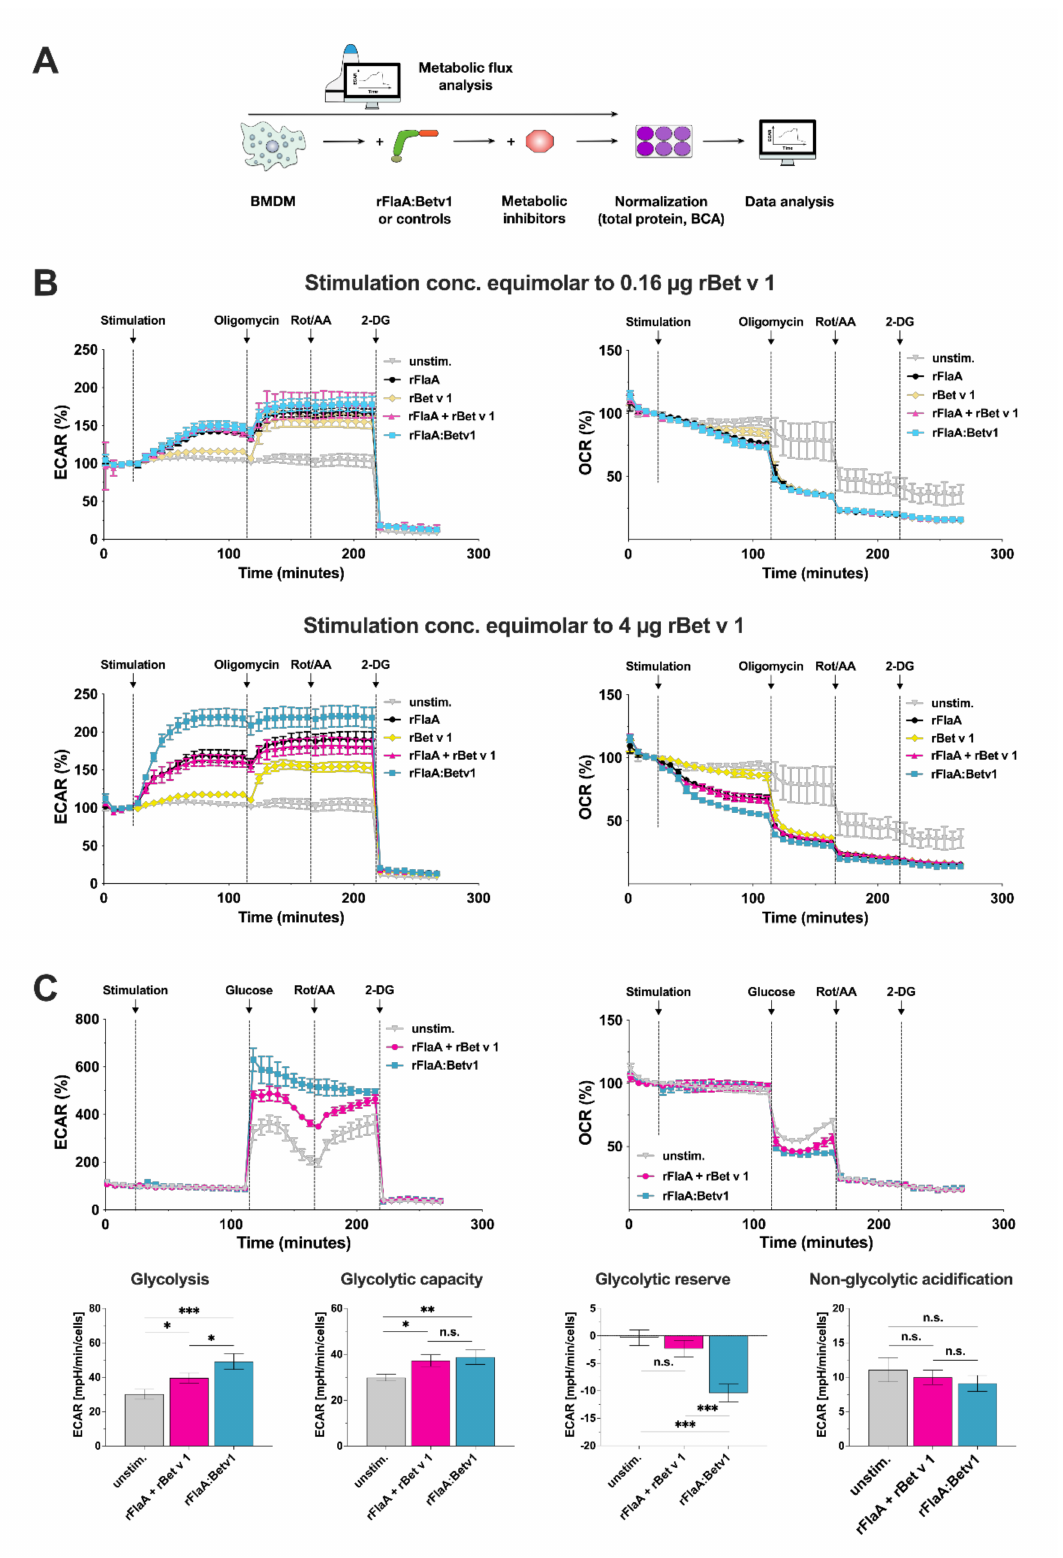
Figure 2. rFlaA:Betv1 triggers a pronounced shift towards glycolysis in BMDMs. Assay scheme for metabolic flux analysis using Seahorse technology ( A ). BMDMs were stimulated with either rFlaA + rBet v 1 or rFlaA:Betv1 in the indicated equimolar concentrations (0.16 µ g rBet v 1 = 8 nM, and 4 µ g rBet v 1 = 200 nM of protein) and analyzed for extracellular acidification rates (ECAR) and oxygen consumption rates (OCR) using Seahorse technology ( B ). 14 cycles (84 min) post- stimulation, ATP synthase, the electron transfer chain, and glycolysis were inhibited by sequential injection of